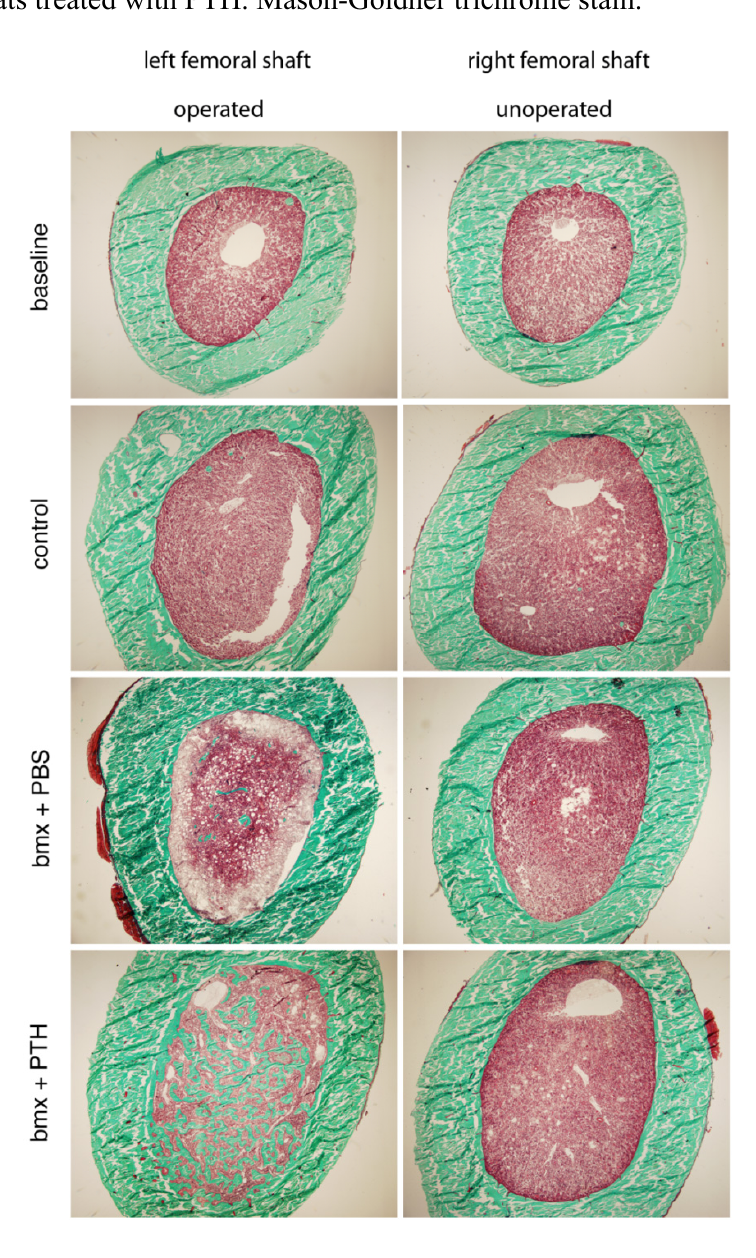
Figure 4. Histologic cross-sections of femoral shafts of left operated and right unoperated femurs from baseline, control and bone marrow-ablated (bmx) rats treated five days per week with PBS or PTH for 28 days. Note the abundant new bone formation in ablated femurs from rats treated with PTH. Mason-Goldner trichrome